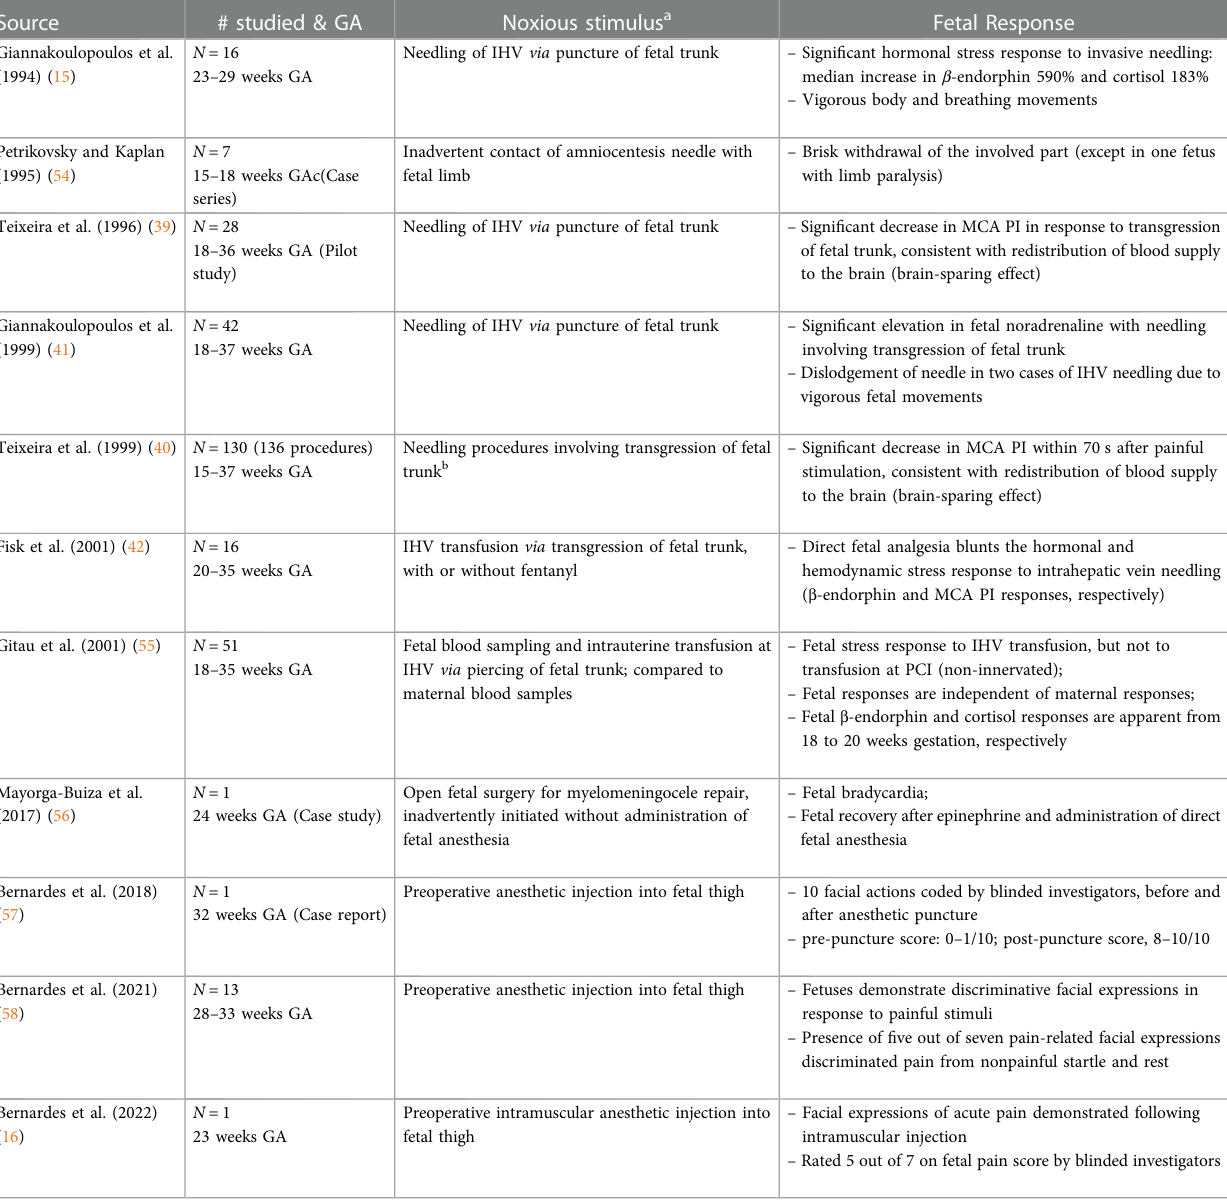
TABLE 1 Fetal responses to noxious